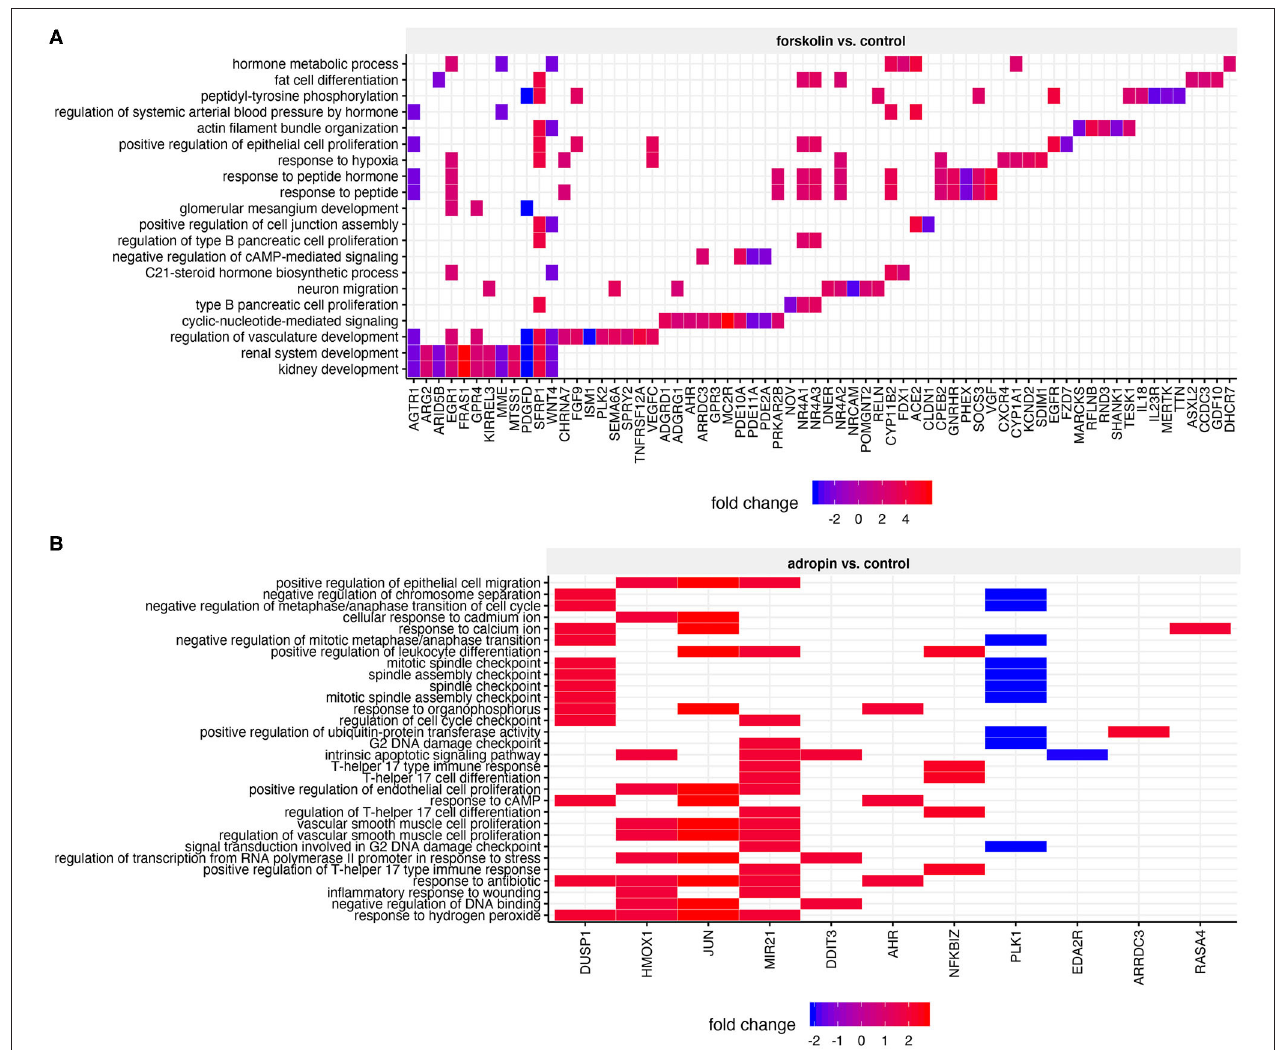
FIGURE 8 | Heatmap of overrepresented gene sets from GO BP (gene ontology–biological process) database, regulated by forskolin (A) and adropin (B) compared to the control group. The graphs show only the GO groups above the established cut-off criteria (adjusted p < 0.05). Fold change values for each DEG were mapped with the appropriate color. Gene symbols of DEGs are shown on the x